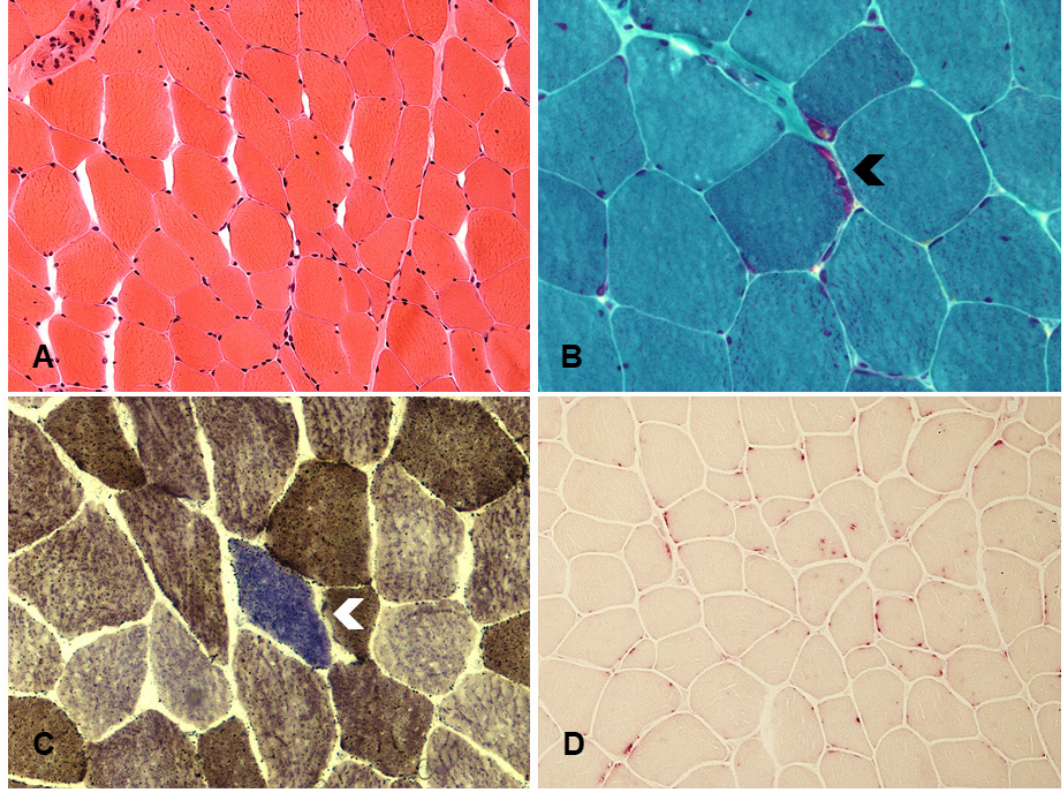
Figure 5. These images document the muscle from a patient with Fabry’s disease on ERT treatment; the biopsy is characterized by abnormal variation in fibre size and a few fibres showing internal nucleation ( A , hematoxylin-eosin, × 20); focal subsarcolemmal accumulation of mitochondria but no ragged red fibres is seen (arrow) ( B —modified Gomori’s trichrome, × 40); a COX-negative fibre is present (blue fibre, arrow) ( C —COX / SDH staining, × 40); there is increase staining with acid phosphatase (red precipitate) that due to subsarcolemmal deposits of lipofuscins and increase in lysosomes ( D —acid phosphatase, × 20).